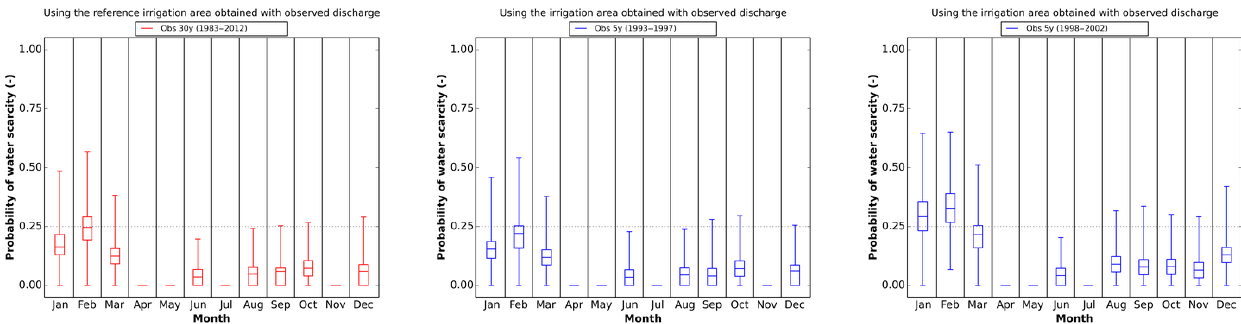
Figure 7. Probability of water scarcity using the reference irrigation area obtained with the observed river discharge of 30 years (Obs 30yr) and the reference surface water availability. Probability of water scarcity using the irrigation area obtained with the observed river discharge of 5 years (Obs 5yr) and the reference surface water availability. Boxplots show the median, interquartile range and minimum–maximum